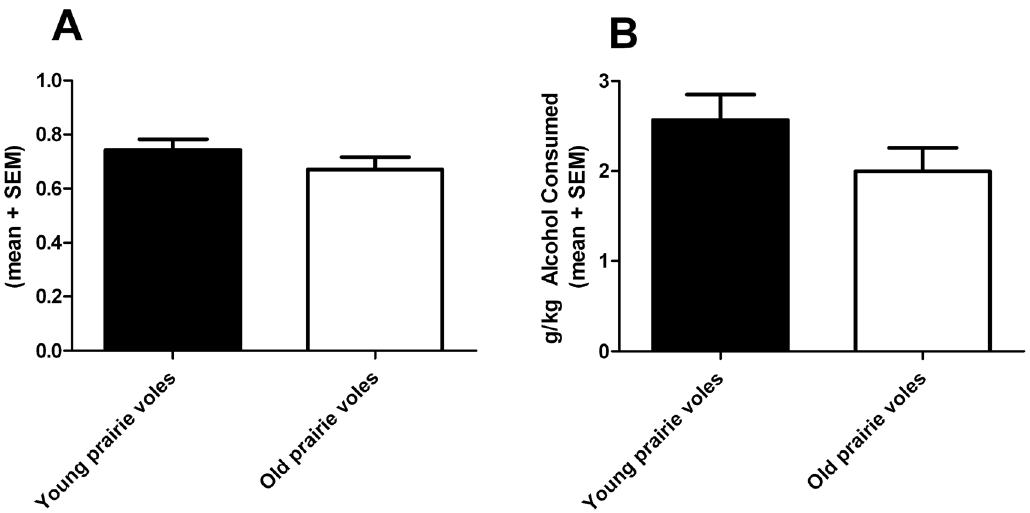
Figure 7. Alcohol drinking in young and old prairie voles. There was no significant difference in preference (A) or intake of alcohol (B) as a result of age or body mass. Values indicate group mean + standard error of the mean (SEM).